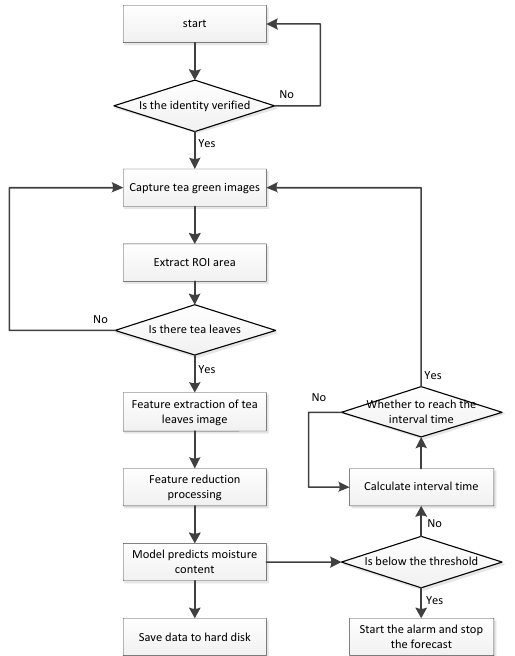
Figure 4. Flow chart of the Yinghong No. 9 tea leaves moisture content detection system.